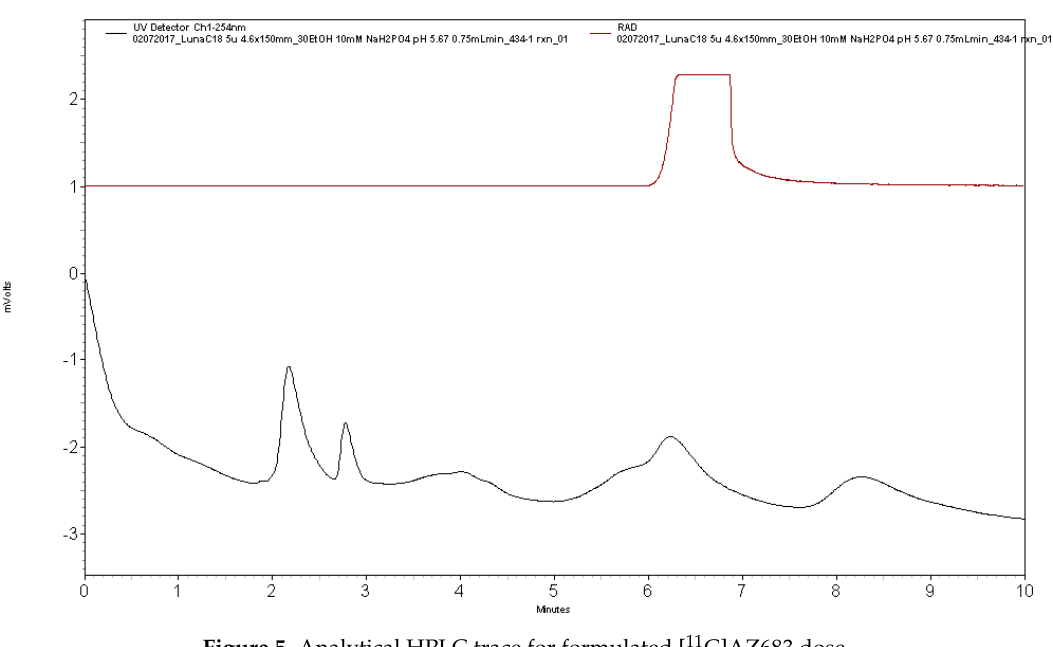
Pharmaceuticals 2018 , 11 , x FOR PEER REVIEW Figure 5. Analytical HPLC trace for formulated [ 11 C]AZ683 dose. Figure 5. Analytical HPLC trace for formulated [ 11 C]AZ683 dose.